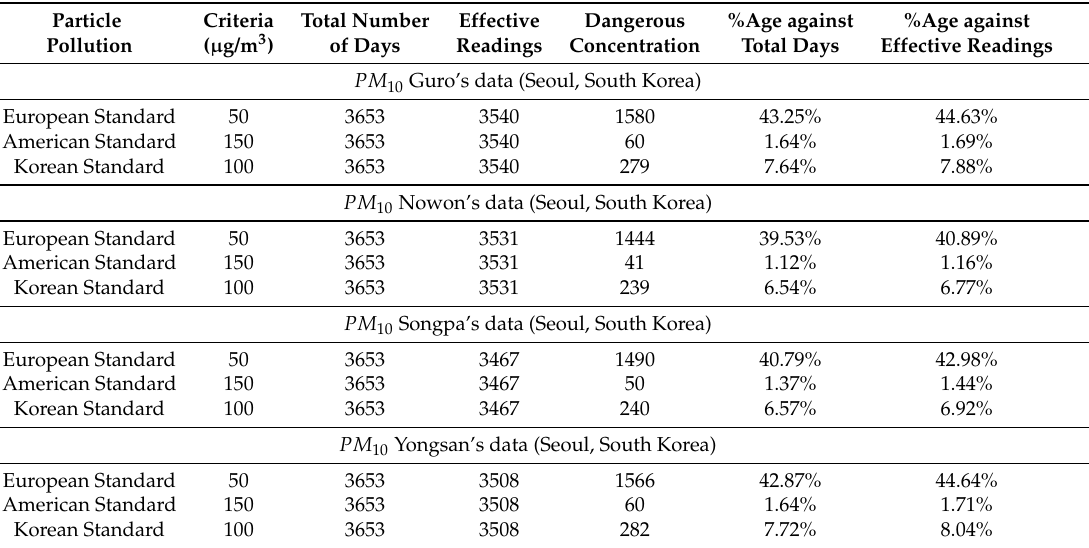
Table 6. Particulate matter ( PM 10 ) location-wise